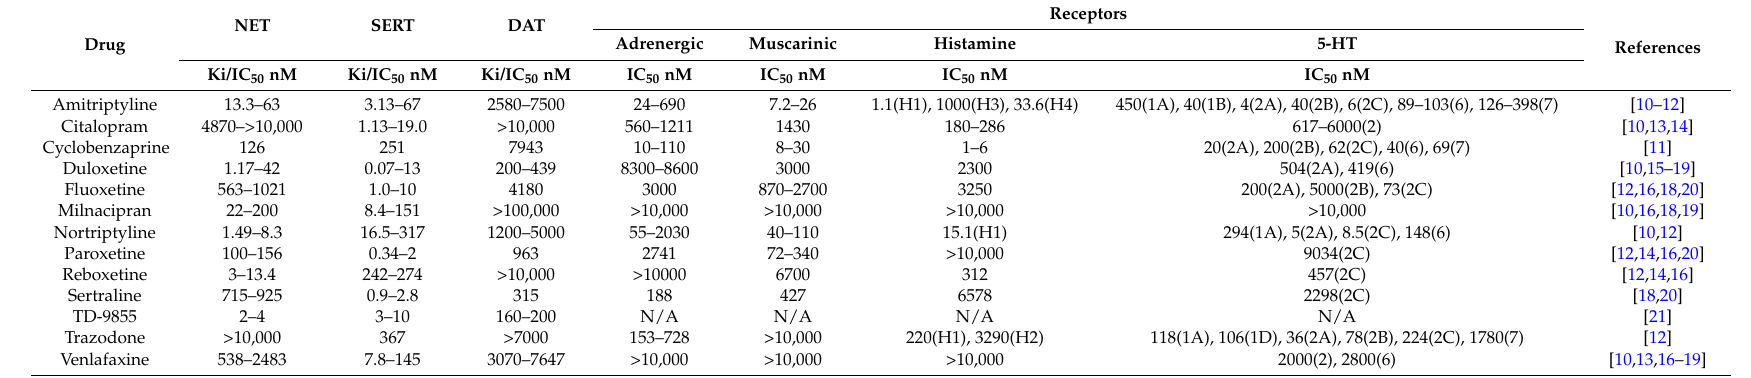
Table 1. Summary of affinities of antidepressant drugs for monoamine reuptake transporters and neurotransmitter receptors. Data are presented as concentrations (nM) representing binding to the protein (Ki value) or exhibiting 50% inhibition of the protein function (IC 50 ); where multiple values are available, a range of the published values is presented. For 5-hydroxytryptamine (5-HT) and histamine receptors, subtypes are indicated in parentheses after the data values. For receptor subtypes not stated, IC 50 value was >10,000 nM. NET is the noradrenaline reuptake transporter; SERT is the serotonin reuptake transporter; DAT is the dopamine reuptake transporter. N/A = not